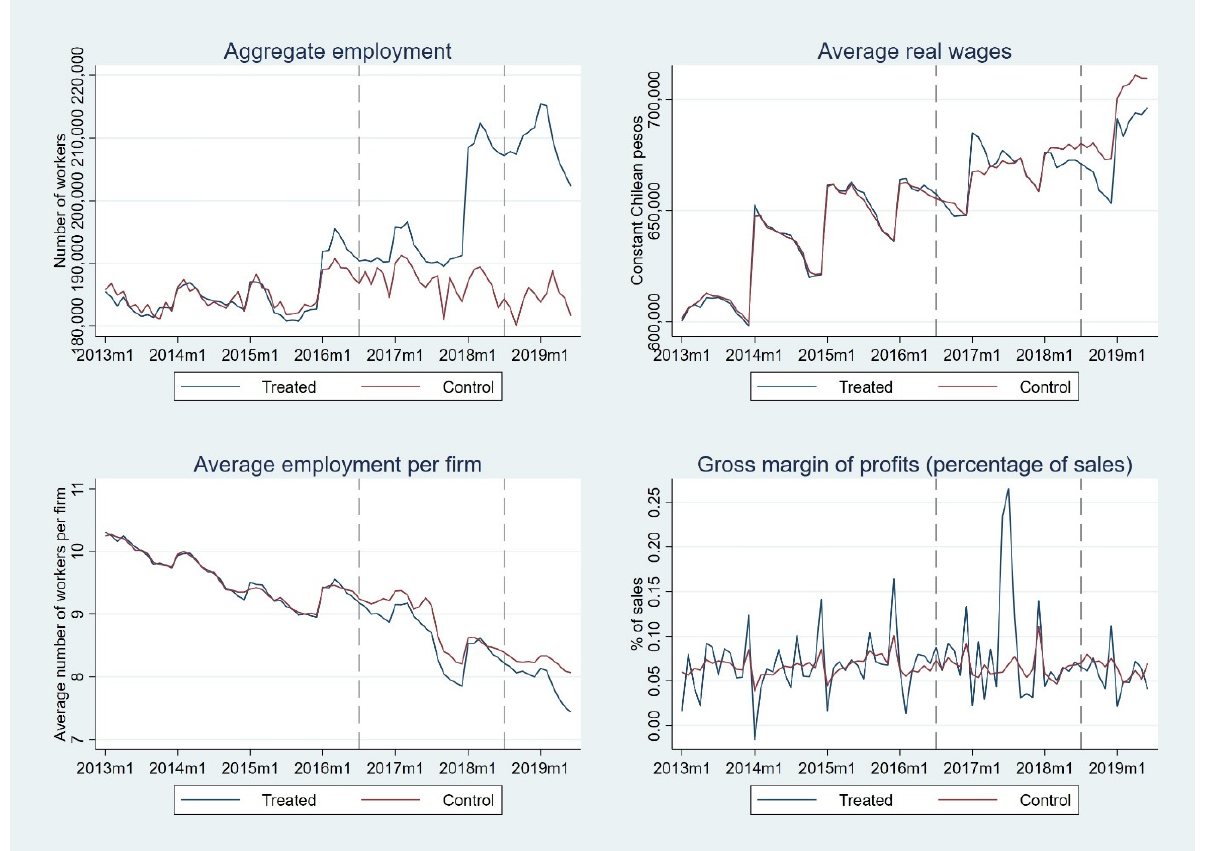
Figure 2. Aggregate employment, real wages, average workers per firm, and gross margin of profits in food and beverage industries, January 2013–June 2019. in food and beverage industries, January 2013–June